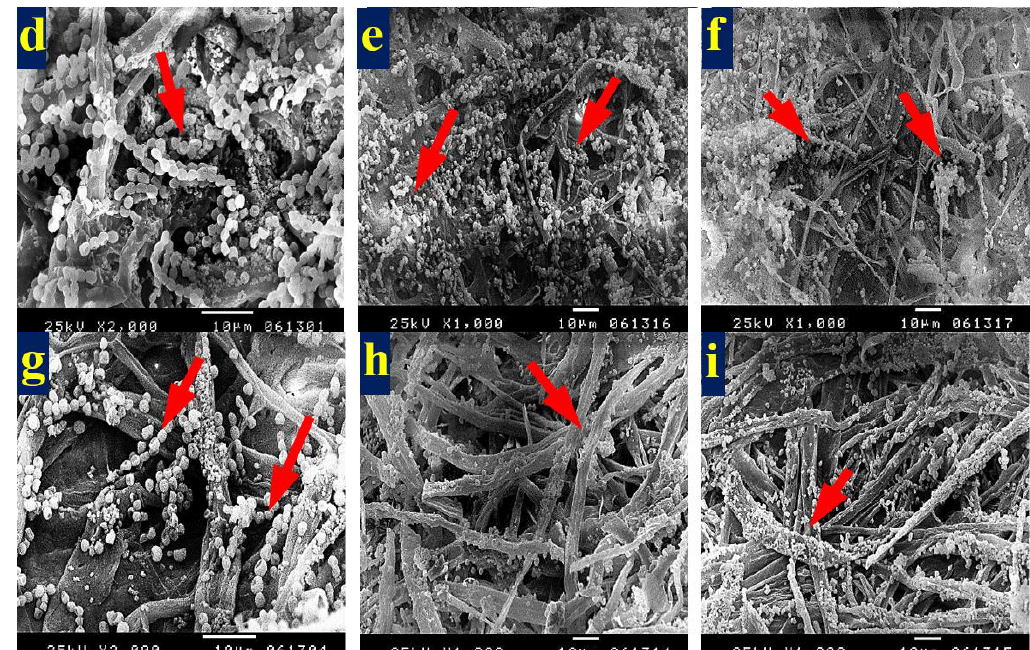
Figure 6. SEM images of E. camaldulensis WB pulp paper manufactured with the addition of different HeOEs and inoculated with A. flavus : ( a ) with M. azedarach HeOE at 1%; ( b ) with S. alba HeOE at 1%; ( c ) with M. grandiflora HeOE at 1%; ( d ) with M. azedarach HeOE at 3%; ( e ) with S. alba HeOE at 3%; ( f ) with M. grandiflora HeOE at 3%; ( g ) with M. azedarach HeOE at 5%; ( h ) with S. alba HeOE at 5%; ( i ) with M. grandiflora HeOE at 5%. Arrows in ( a , d , g ) indicate the growth and density of the fungal spores on the sample fibers, arrows in (b, e, h) indicate the growth and interaction of the fungal spores with the fibers, and arrows in ( c , f , i ) refer to a slightly moderate growth of fungal mycelia and spores on the sample fibers.